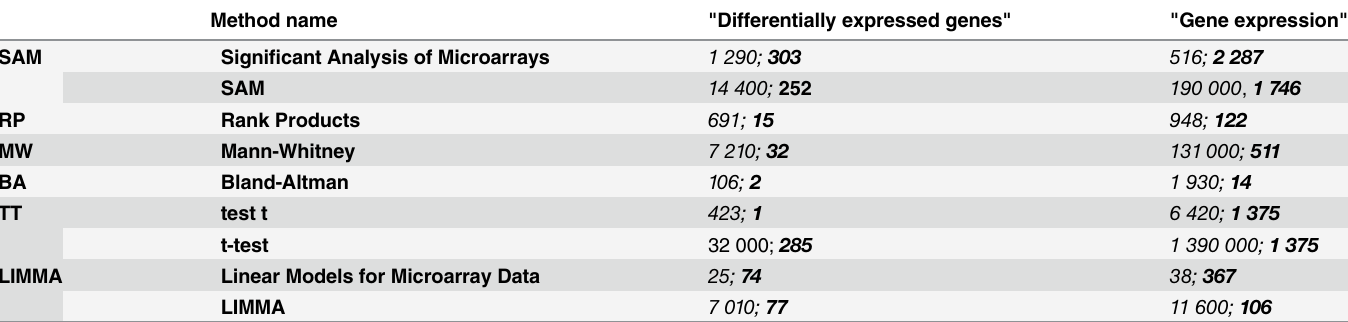
Table 1. Frequency of hits: method name along with “ differentially expressed genes ” and “ gene expression ” phrases ( Google Scholar , PubMed ).